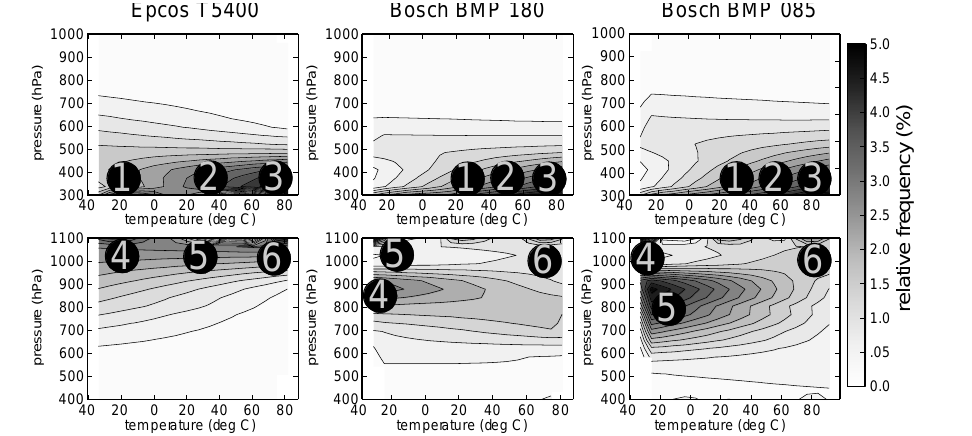
Figure 2. Recommended six calibration points for second order polynomial barometric pressure sensor calibration; frequency of the first three calibration points shown in the upper part; frequency of the last three calibration points shown in the lower part of the